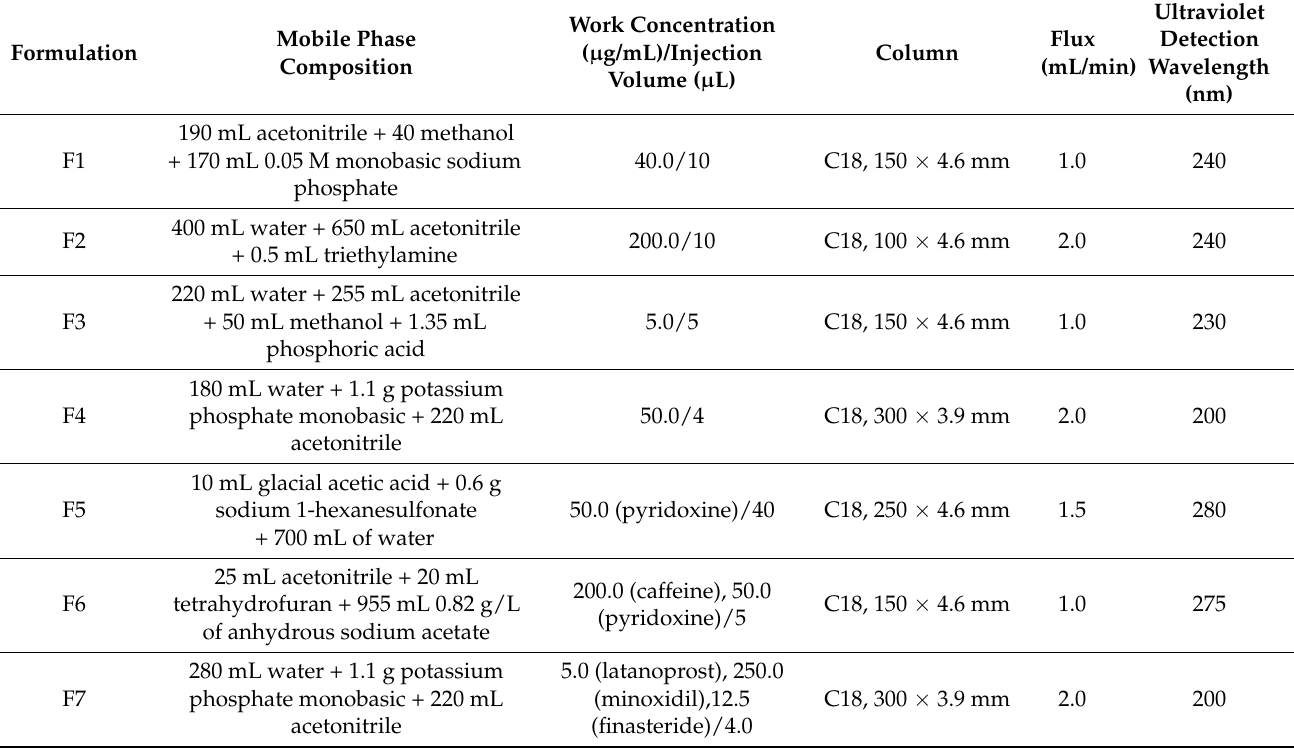
Table 2. Chromatographic Conditions Used in the Compatibility